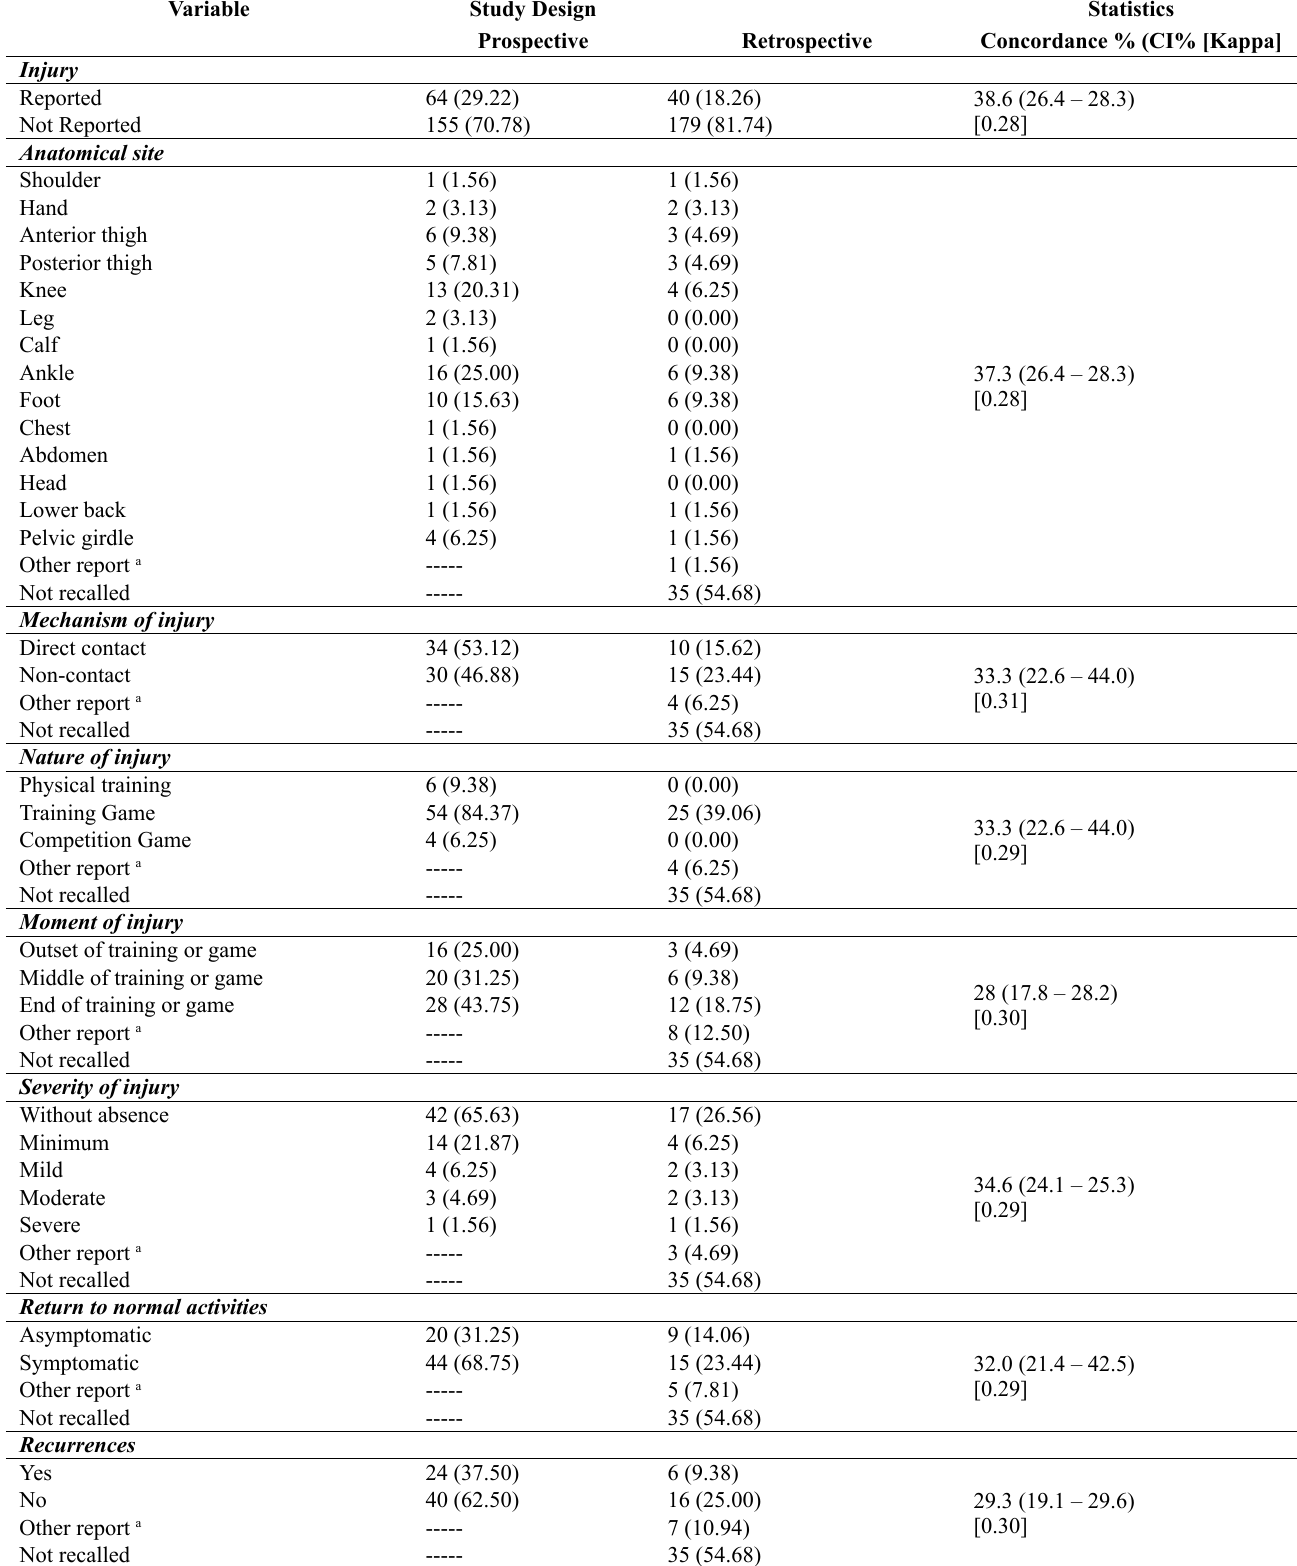
Table 1. Distribution of cases n (%), followed by the percentage of concordance and concordance interval and the value of Cohen’s Kappa concordance test for prospective and retrospective answers according to the occurrence of injury, anatomical site affected, mechanism of injury, nature of injury, moment of injury, severity of injury, return to normal activities, and